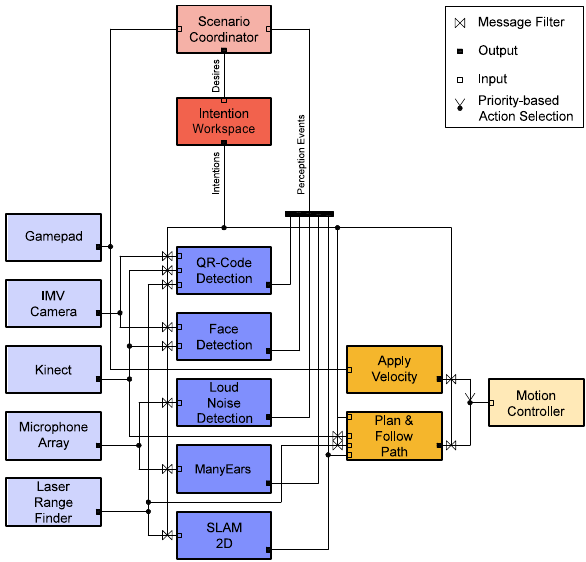
Figure 9: HBBA implementation for the tour-guide